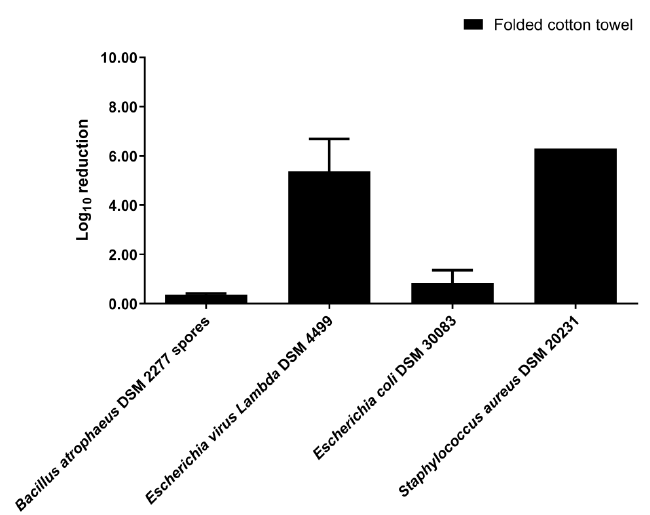
Figure 3. Log 10 reduction achieved in disinfection of a folded cotton towel of 460 × 720 mm by nebulization in a 0.08 m 3 closet. VIRCOV BAC 360 disinfectant was used at 1/3 ( v / v ) dilution. The indicators tested were B. atrophaeus DSM 2277 spores, bacteriophage Lambda DSM 4499, Escherichia coli DSM 30083, and Staphylococcus aureus DSM 20231. The disinfection time consisted of 2 min of disinfectant nebulization plus 5 min of rest without nebulization. The error bars in the graph rep- resent the standard deviation of the mean of three replicates ( n = 3). The disinfection by nebulization of the footwear item significantly reduced the number of viable E. coli DSM 30083 ( p -value < 0.0001) and S. aureus DSM 20231 cells ( p -value < 0.0001) (Supplementary Materials Figure S8). The log 10 reductions of E. coli DSM 30083 and S. aureus DSM 20231 were 5.91 ± 2.55 (99.96% elimination rate) and 6.30 ± 0.001 (100% elimination rate), respectively (Figure 4). However, for B. atrophaeus DSM 2277 spores and bacteriophage Lambda DSM 4499, disinfection by nebulization in the 0.08 m 3 closet did not significantly reduce their numbers ( p -value > 0.05 for both) (Supple- mentary Materials Figure S8).